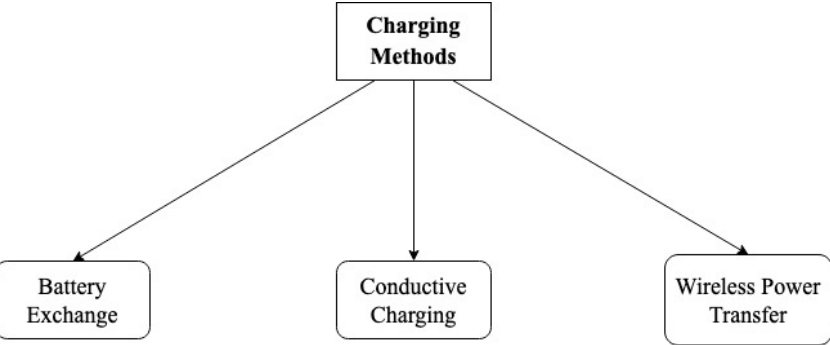
Figure 12. The three charging methods currently available for electric